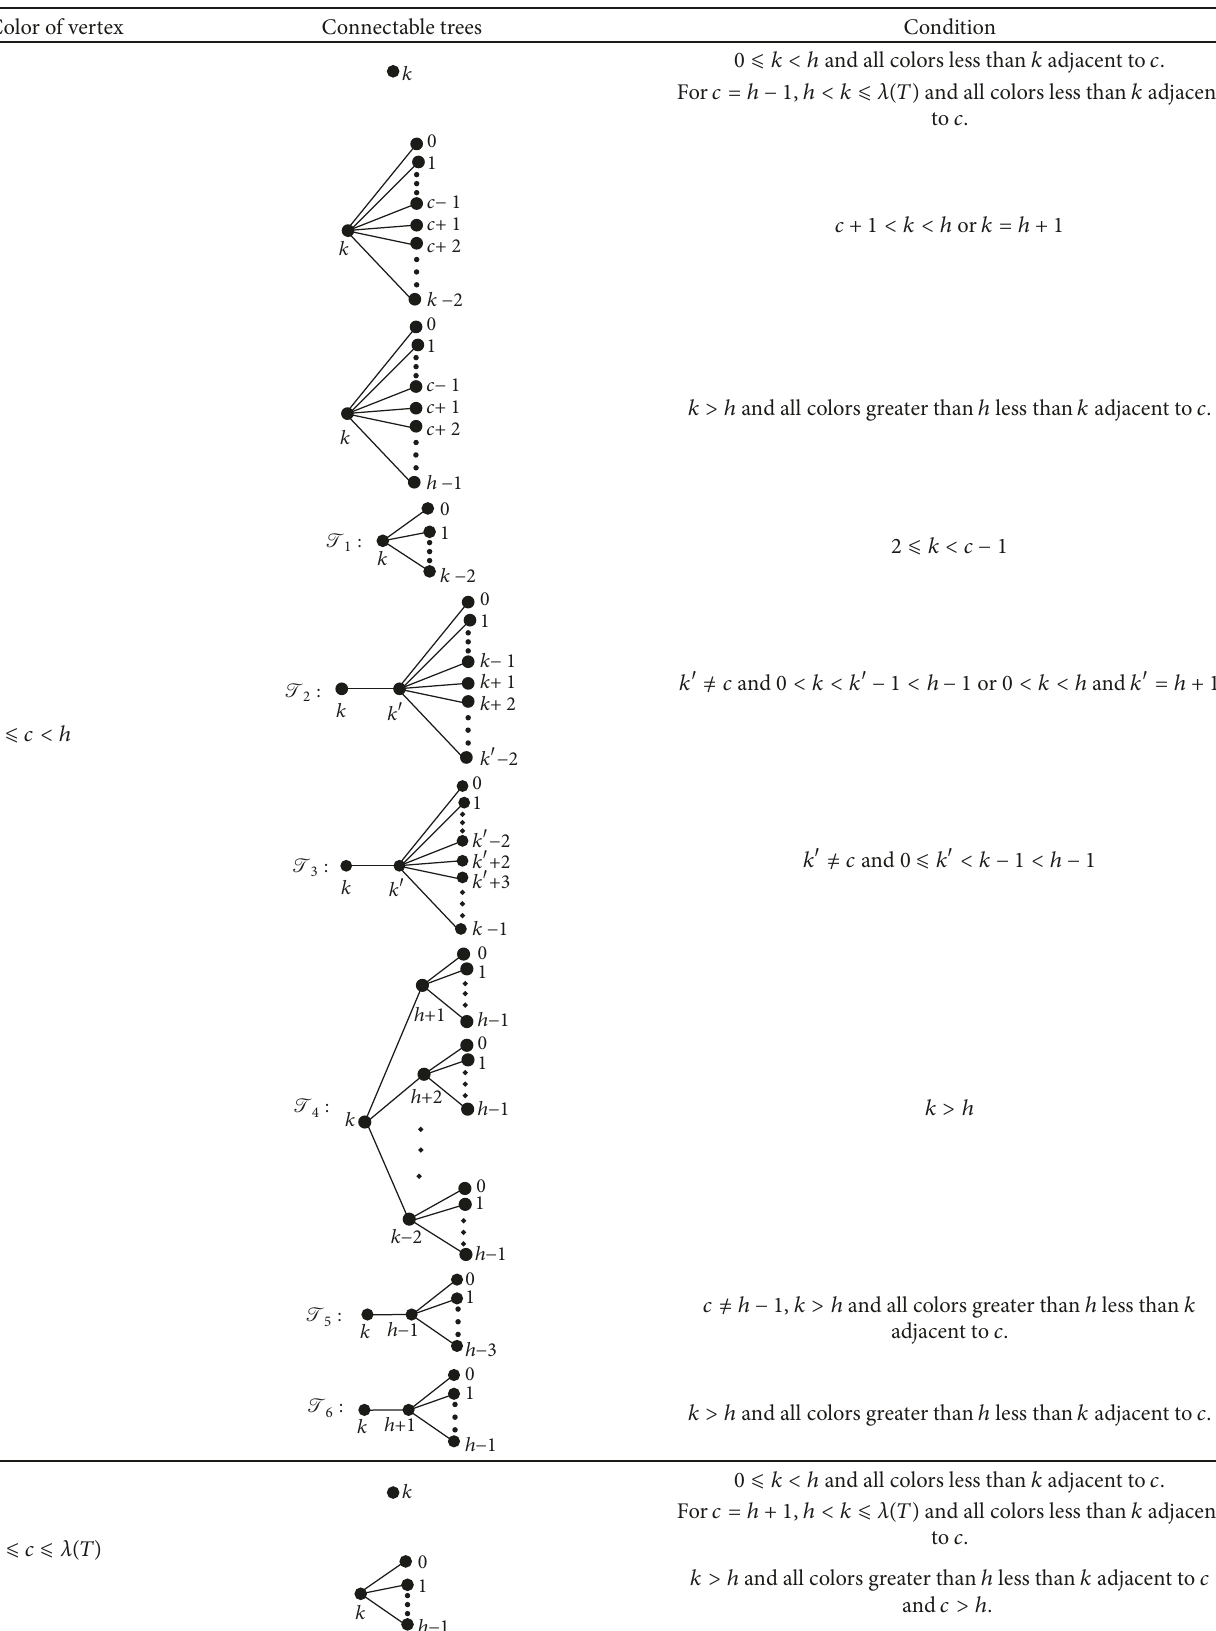
Table 4: Trees connectable for a vertex colored 𝑐 in a one-hole tree with hole ℎ . Color of